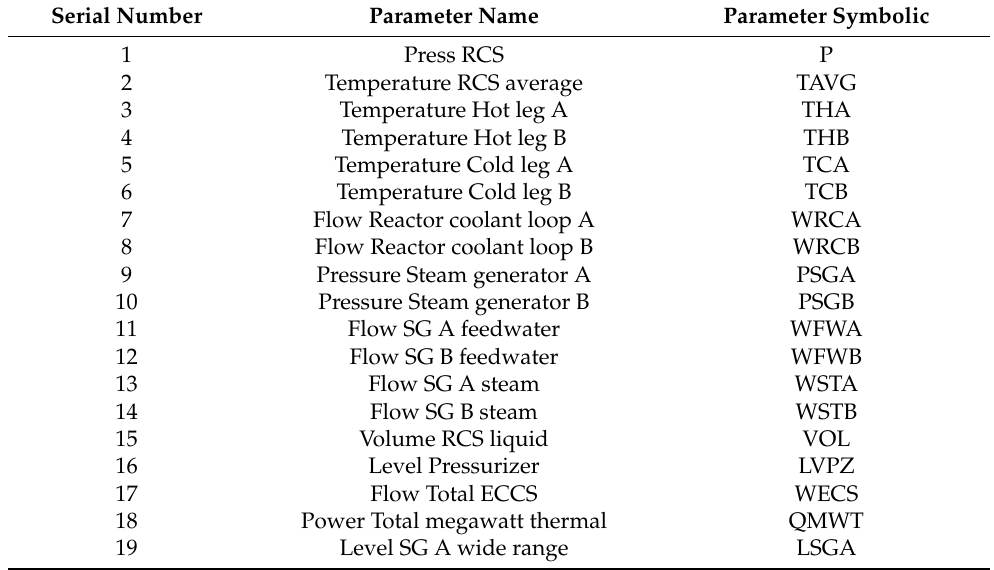
Table 7. Fault parameter names and